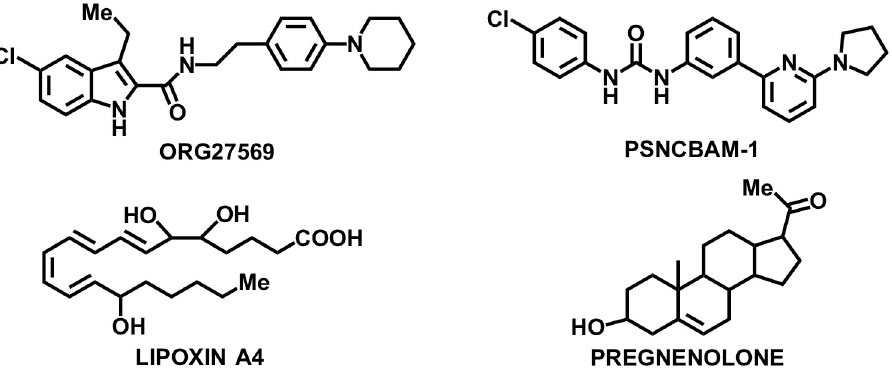
Fig 1. Examples of reported allosteric modulators of the CB 1